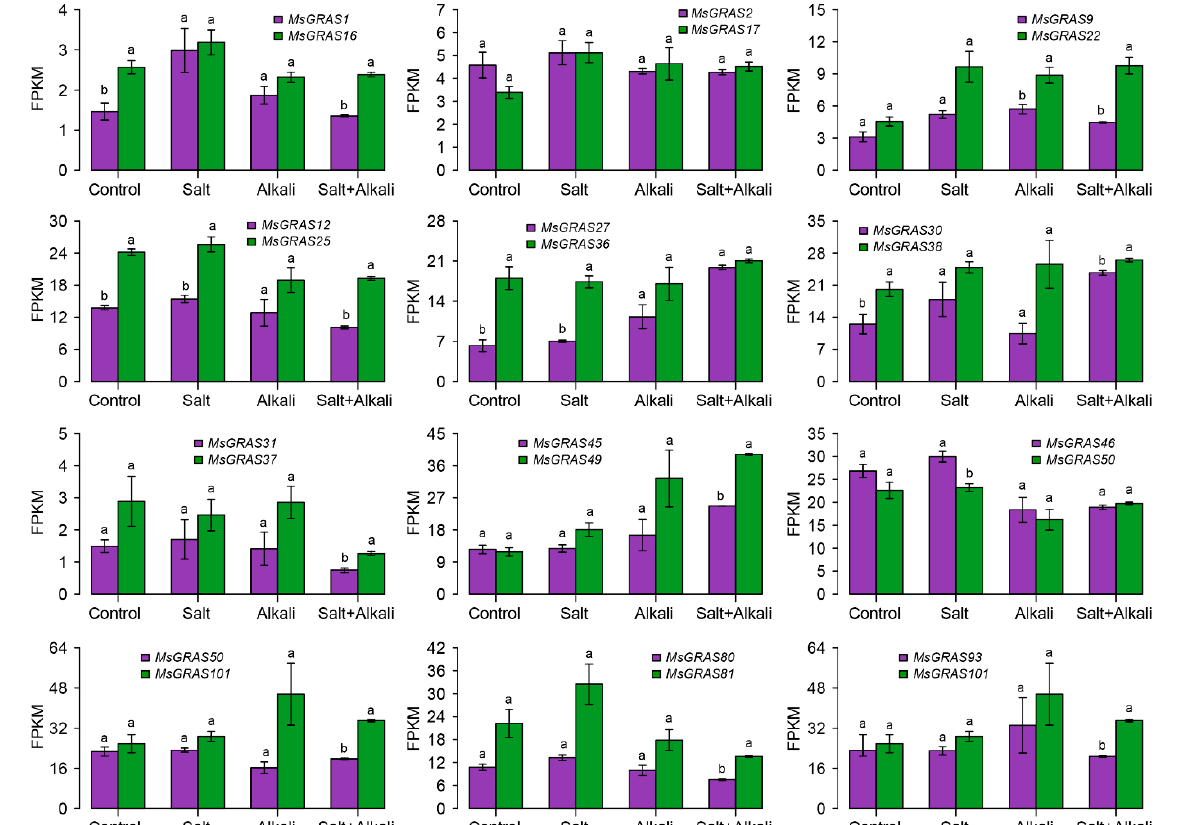
Figure 6. Differential expression of MsGRAS paralogous pairs under salt, alkali and mixed salt-alkali stresses. The same letters (a/a) mean no significant differences between paralogous genes. The different letters (a/b) represent significant differences between paralogous genes ( p < 0.05). Error bars indicate the standard error (SE) of three biological replicates.